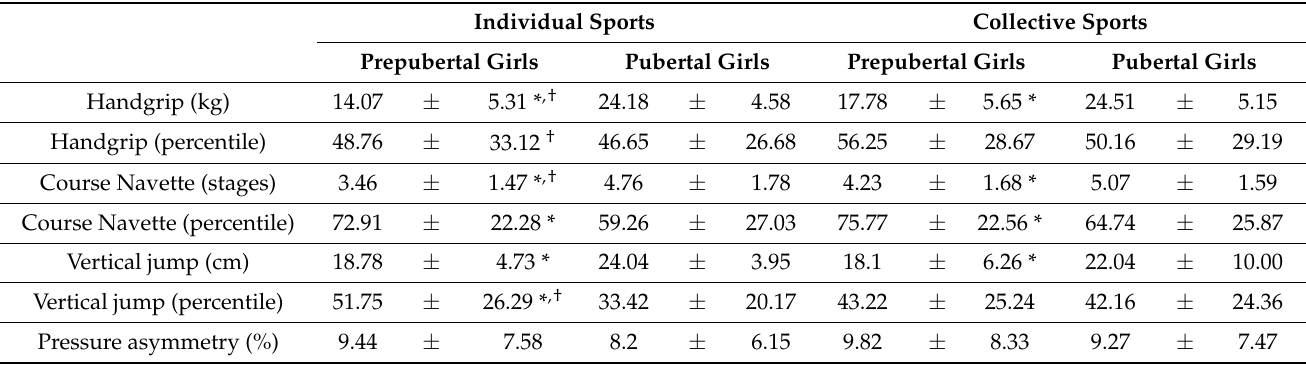
Table 3. Physical Parameters According to the Typology of Sport in Prepubertal and Pubertal